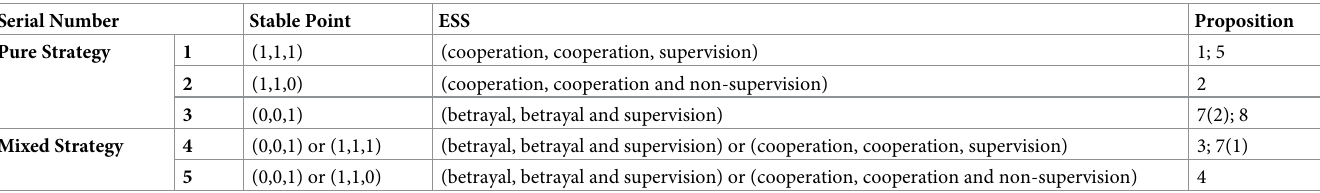
Table 6. Evolution results of each proposition in tripartite